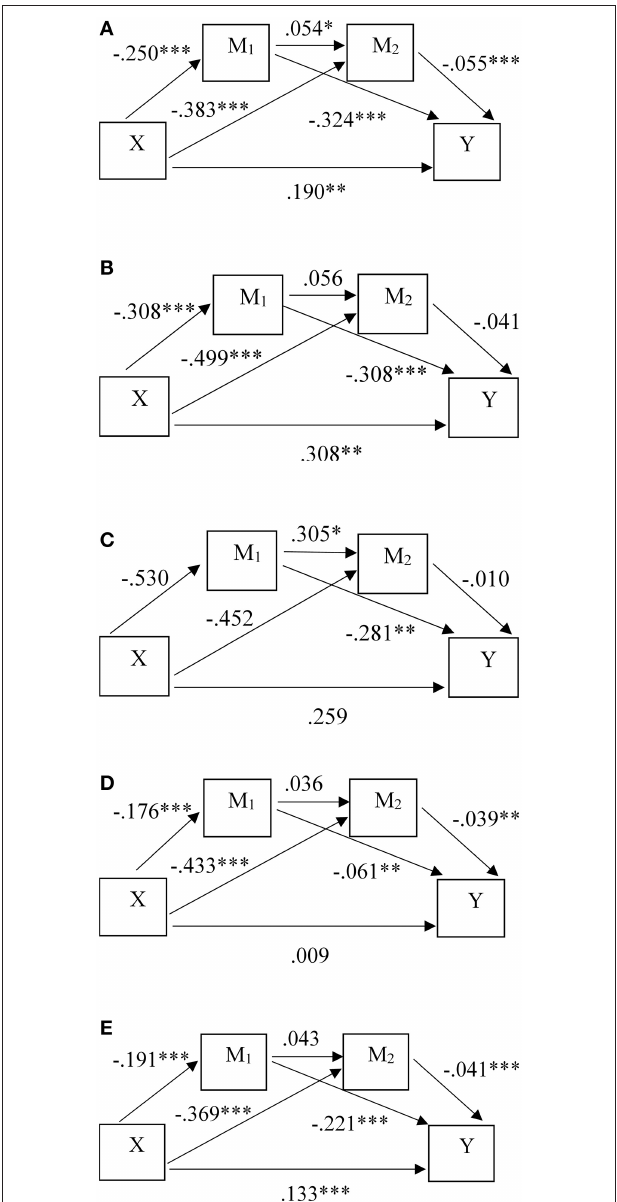
FIGURE 2 | Predictive model effects for the HE student groups: (A) all students ( N = 2,480), (B) low academic stress students ( N = 63), (C) high academic stress students ( N = 839), (D) depressed students ( N = 404), (E) non-depressed students ( N = 2,076). *significant at p < 0.05, **significant at p < 0.01, ***significant at p < 0.001.